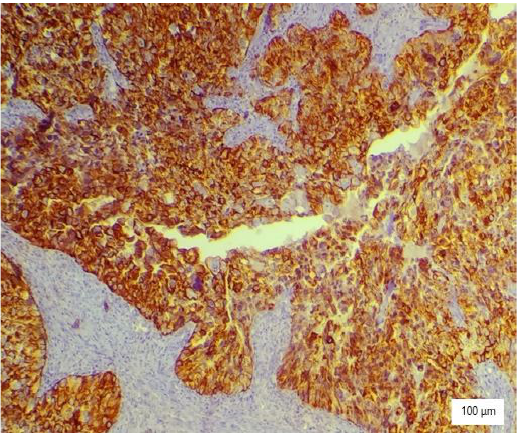
Figure 5. Positive periodic acid – Schiff staining in the cytoplasm (PAS ×100).